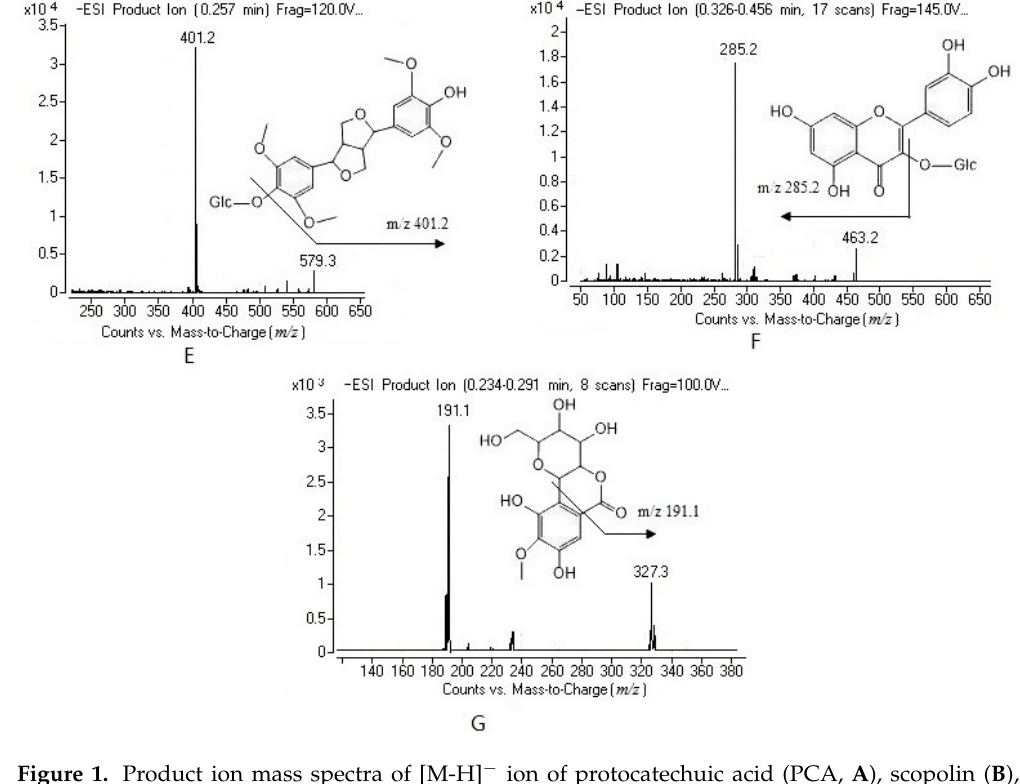
Figure 1. Product ion mass spectra of [M-H] − ion of protocatechuic acid (PCA, A ), scopolin ( B ), ( − )-pinoresinol-4,4’-di- O - β - D -glucopyranoside (PDG, C ), acanthoside D ( D ), acanthoside B ( E ), hyperin ( F ) and bergenin ( G ).